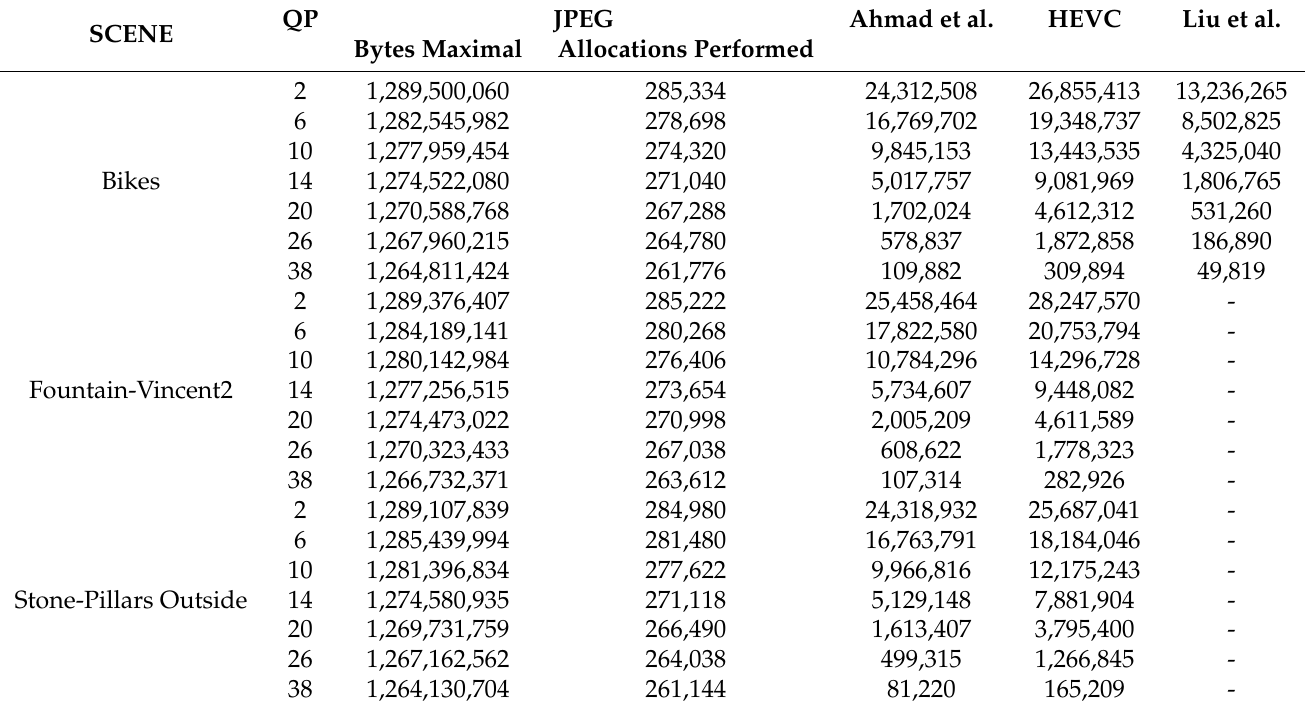
Table 1. The total number of bytes written to file during compression for three datasets using JPEG, Ahmad et al., Liu et al., and HEVC